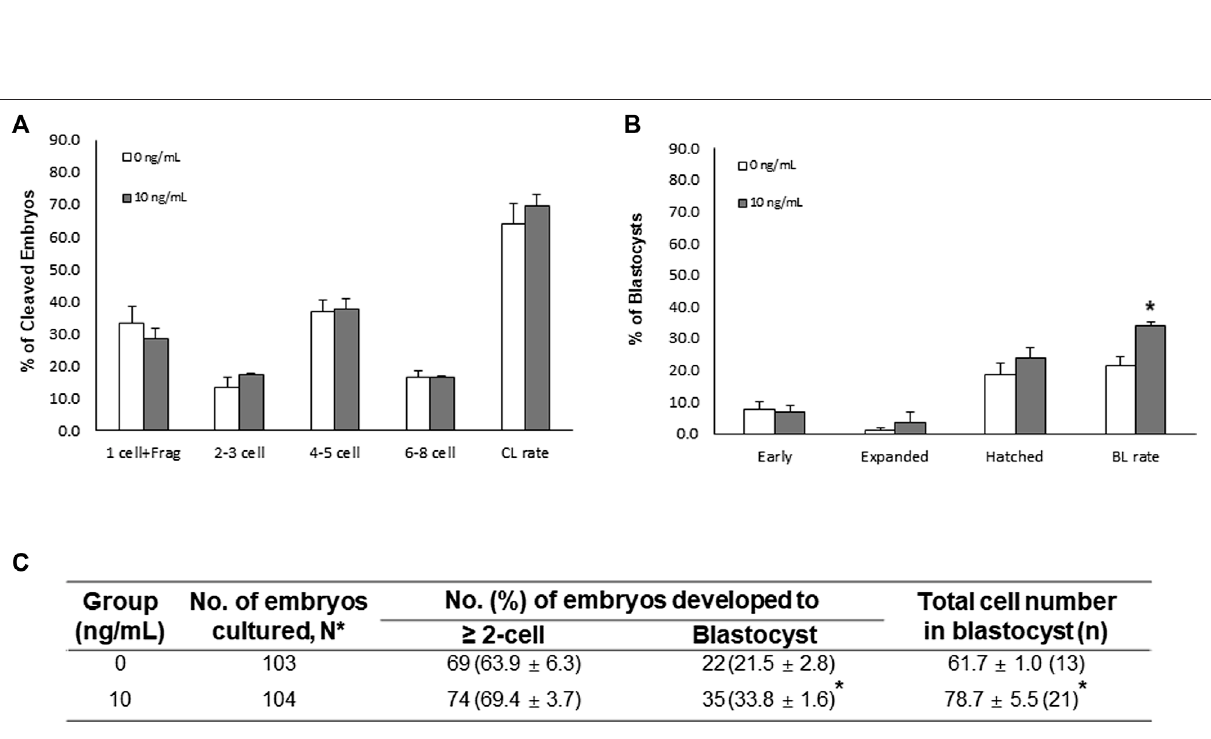
Frontiers in Cell and Developmental Biology |